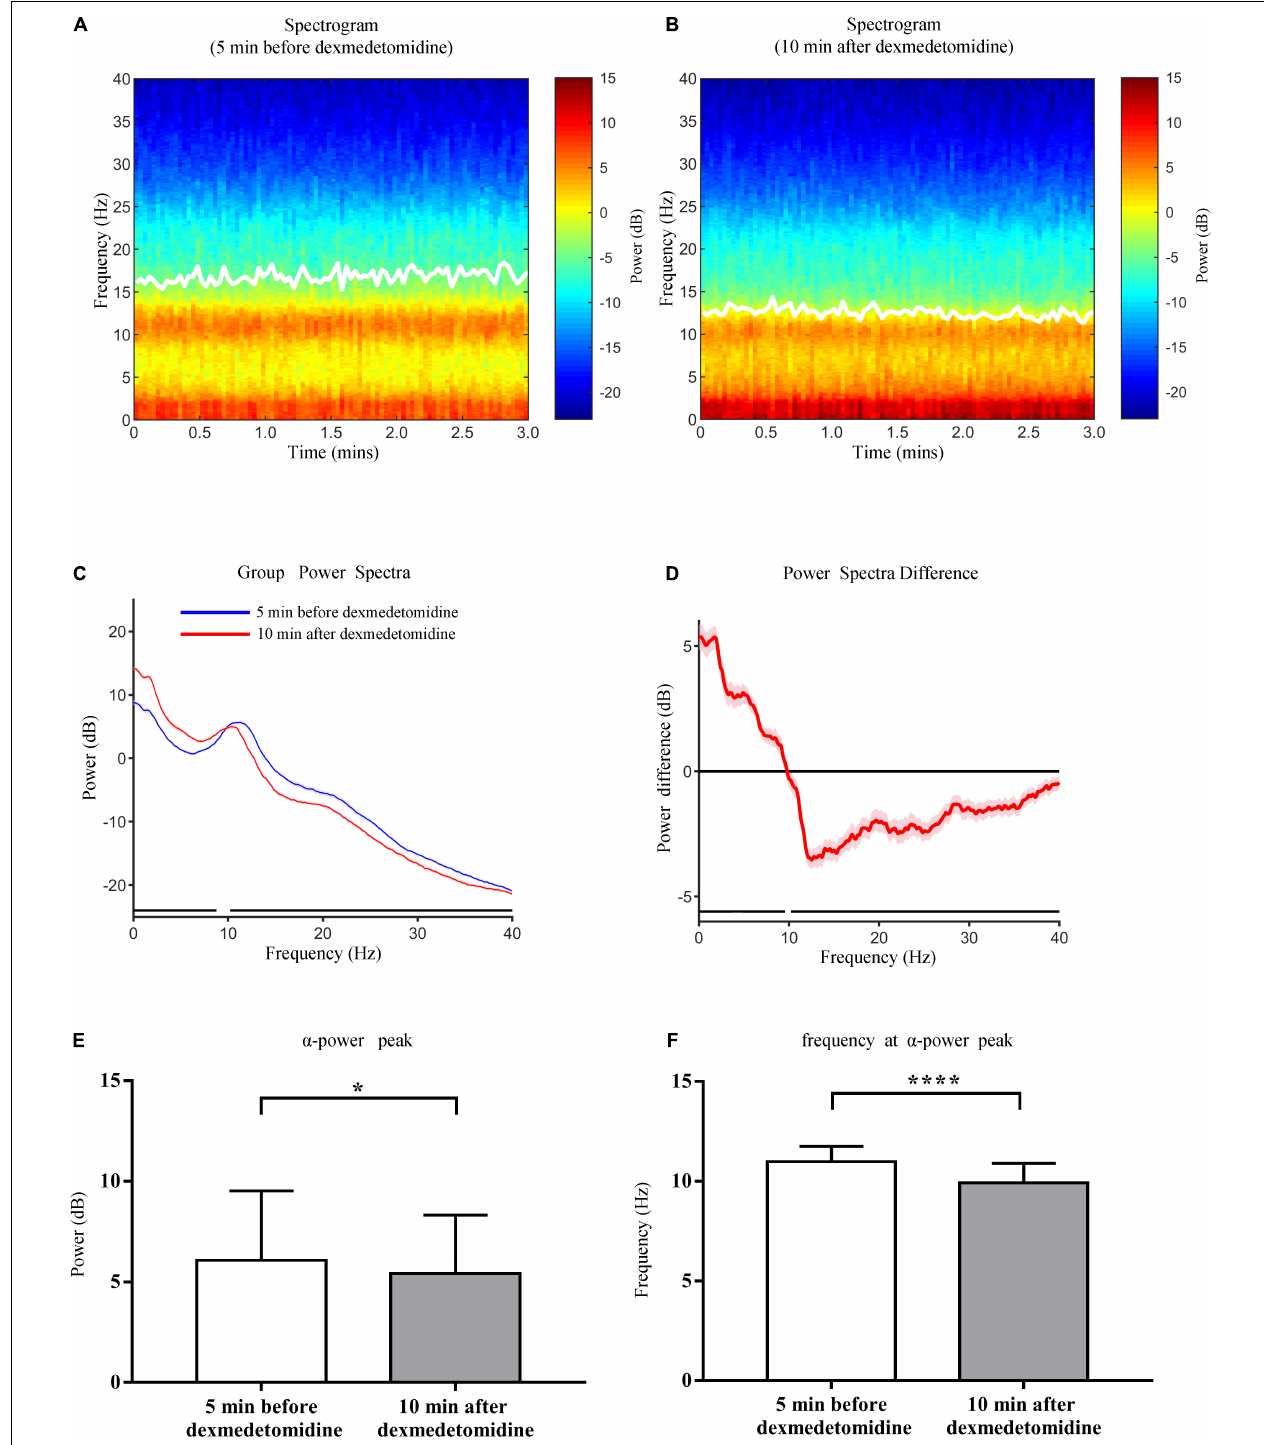
FIGURE 4 | Comparison of group-level power spectral analysis 5 min before and 10 min after dexmedetomidine infusion. (A) Frontal spectrogram of 23 cases 5 min before dexmedetomidine infusion. (B) Frontal spectrogram 10 min after dexmedetomidine infusion. White solid lines in (A,B) represent SEF95. (C) Comparison of group-level power spectra 5 min before (blue line) and 10 min after (red line) dexmedetomidine infusion, shading represents 95% CI range. (D) Median spectral power difference of two periods at each frequency, shading represents 95% CI range. The horizontal black lines in (C,D) represent frequency segments with significant differences across two time periods (0–9.56 Hz and 10.22–40 Hz). (E) Comparison of power of α peaks 5 min before and 10 min after dexmedetomidine infusion. Data are given as mean ± SD (Paired t- test probability is indicated as: * P < 0.05; **** P < 0.0001, n = 23). (F) Comparison of frequencies of α peaks. Details as in (E) .